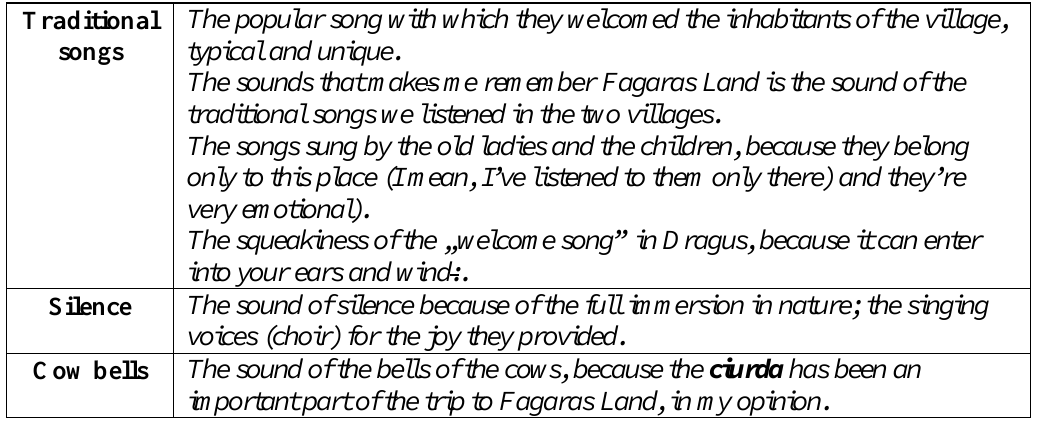
Table 4: Description of the Sounds associated by Italian Participants with their Experience in Fagaras Land Traditional